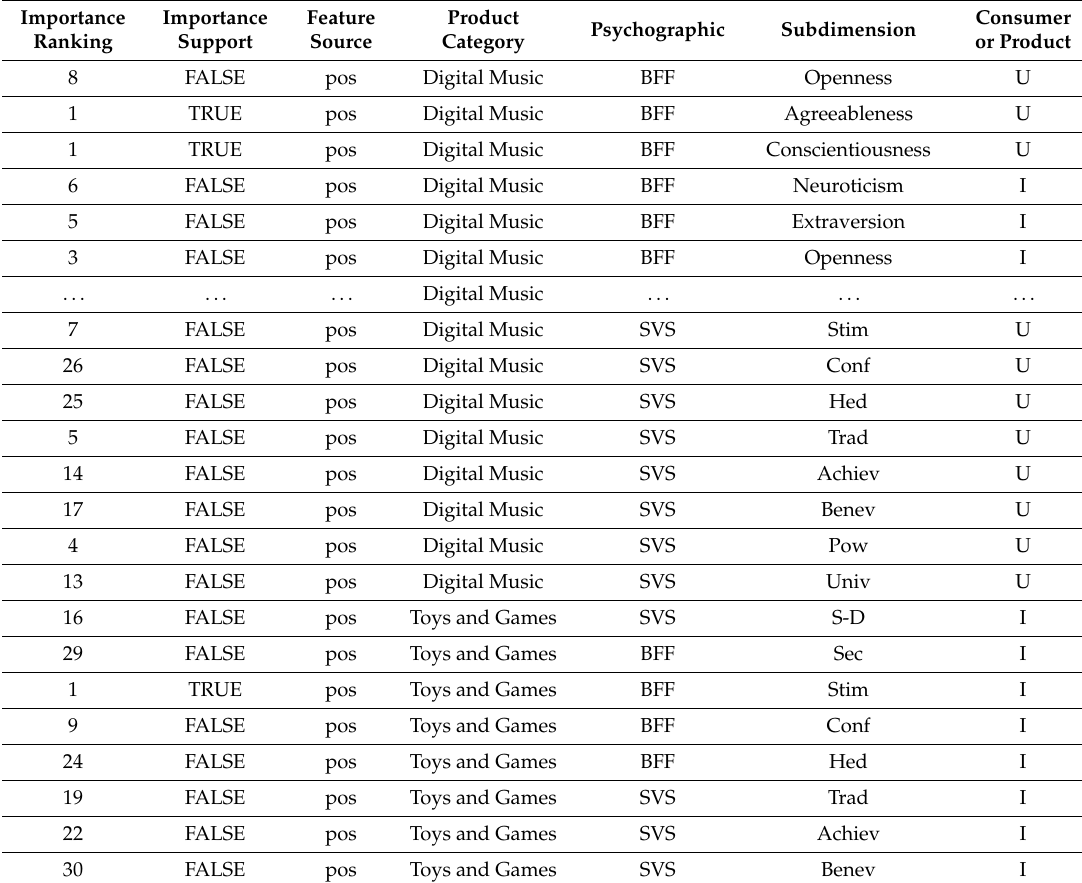
Table 8. Importance of di ff erent subdimensions of psychographic variable in predicting and explaining user